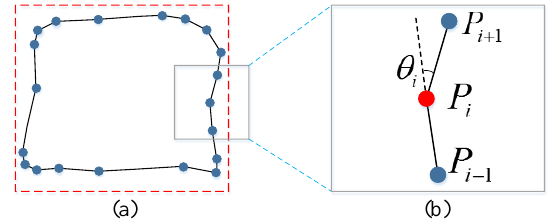
Figure 2. Determination of the internal energy item. (a) The redundant nodes of the initial LiDAR-derived building